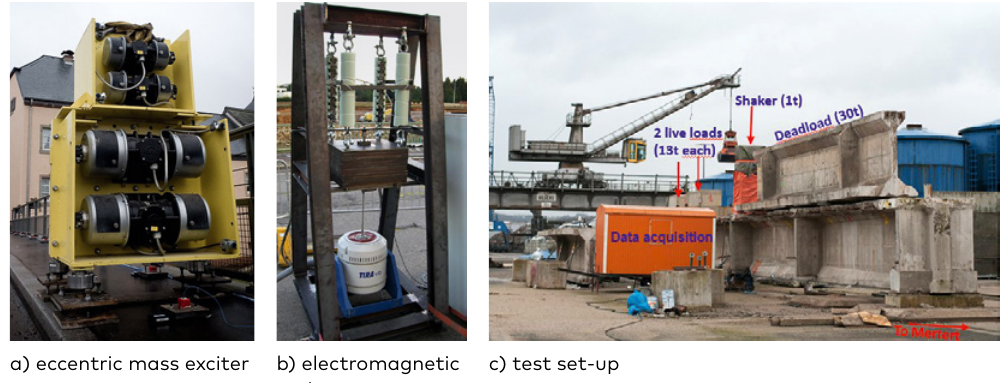
Figure 2. Forced harmonic exciters and the test